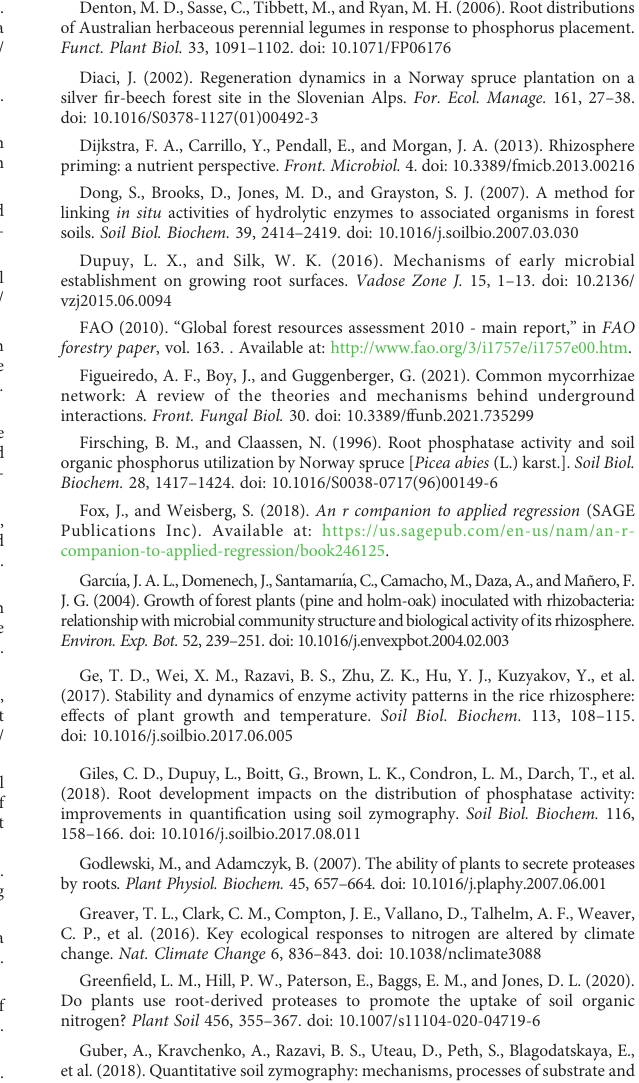
SUPPLEMENTARY FIGURE 1 Distribution of enzyme activities on the rhizoplane of European beech. The curves present the power-law fi tting of enzyme activities as a